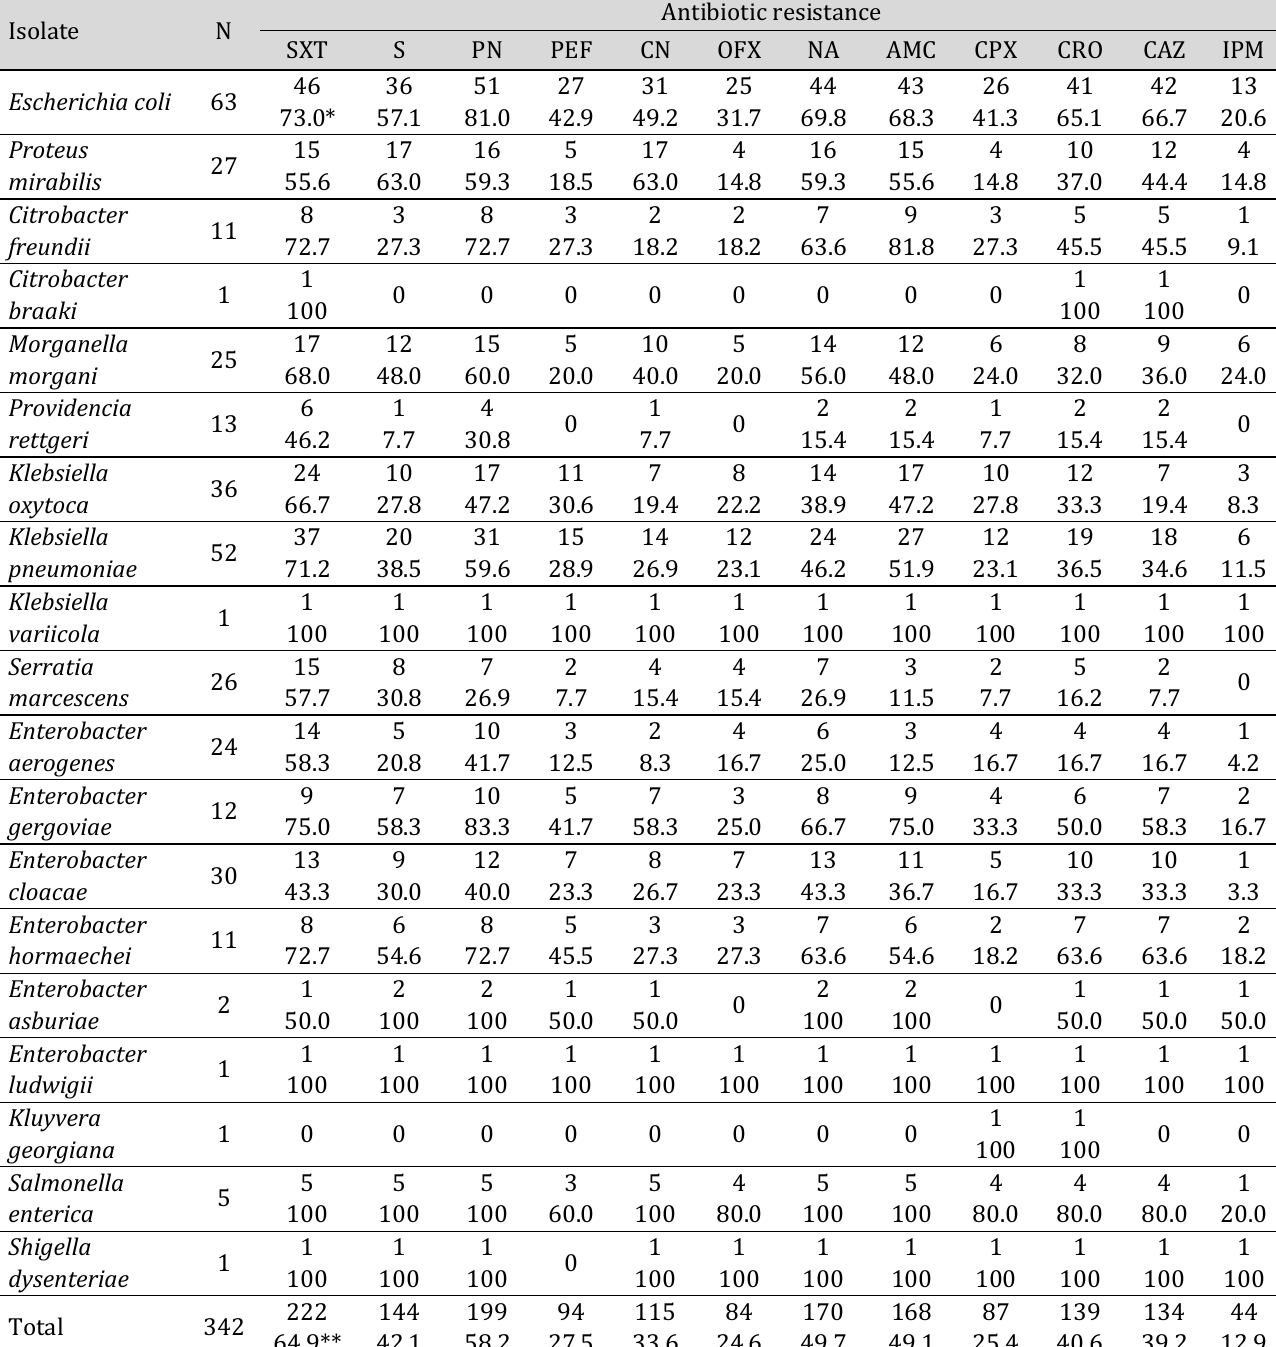
Table 2. Antibiotic resistance pattern of the isolated Enterobacteriaceae species from water sources in Adamawa-North senatorial zone